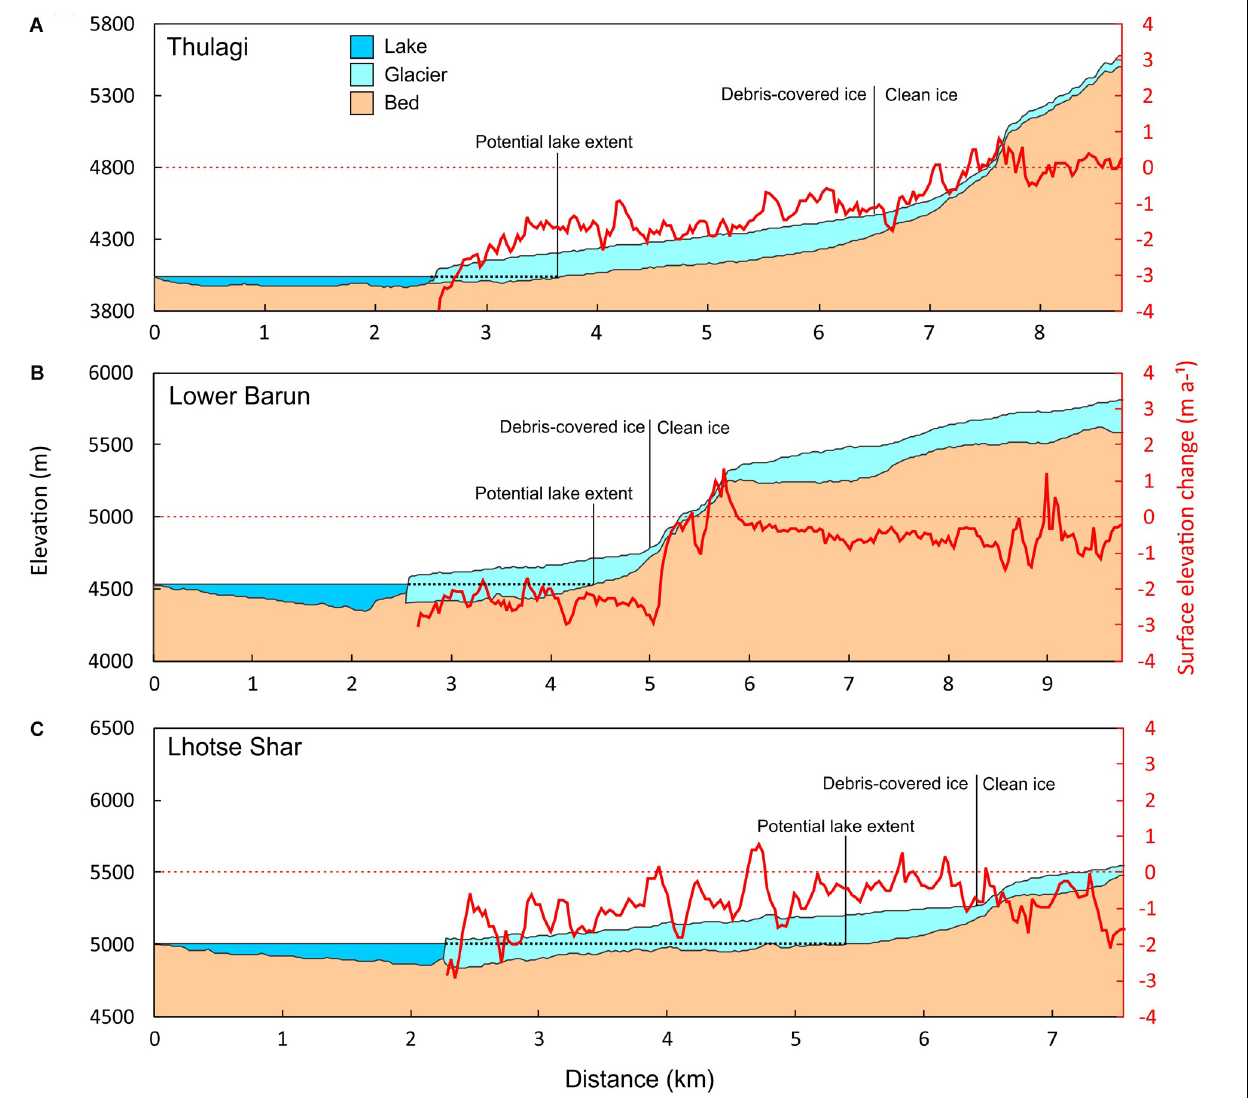
FIGURE 6 | Centreline profiles (shown in Figure 1 ) for (A) Thulagi, (B) Lower Barun and (C) Lhotse Shar/Imja Lake. Lake bathymetry data are from Haritashya et al. (2018), surface elevation change data are from Brun et al. (2017b), ice thickness data are from Farinotti et al. (2019) and glacier topography from the AW3D30